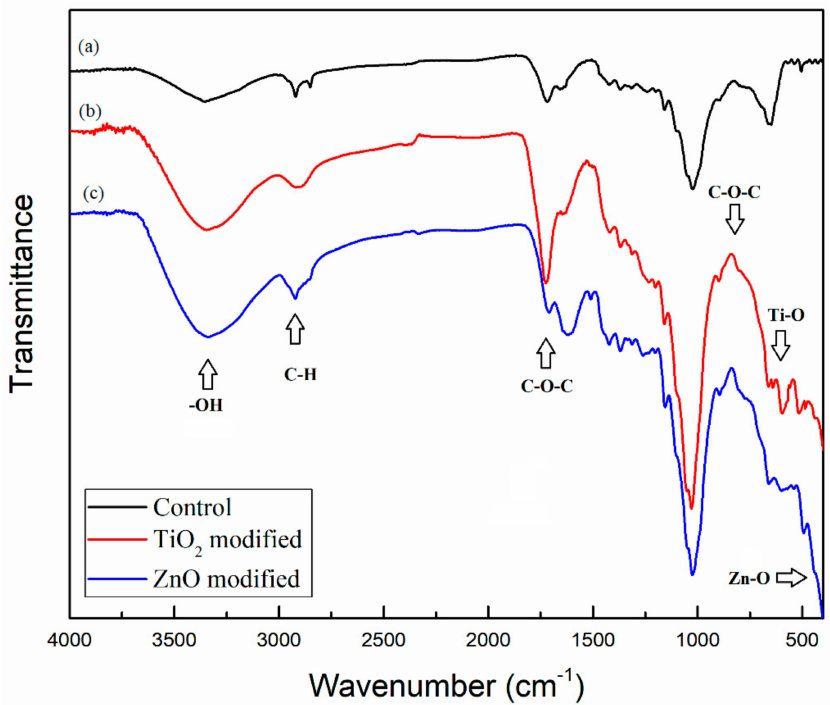
Figure 7. FTIR of Larix spp. wood samples before and after surface modification: ( a ) Control; ( b ) TiO 2 modified wood; ( c ) ZnO modified